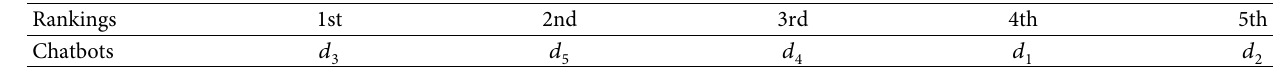
Figure 3: Score, Accuracy & Ranking Comparison for F Table 11: Rankings of chatbots under ( B , ⊞ ) .